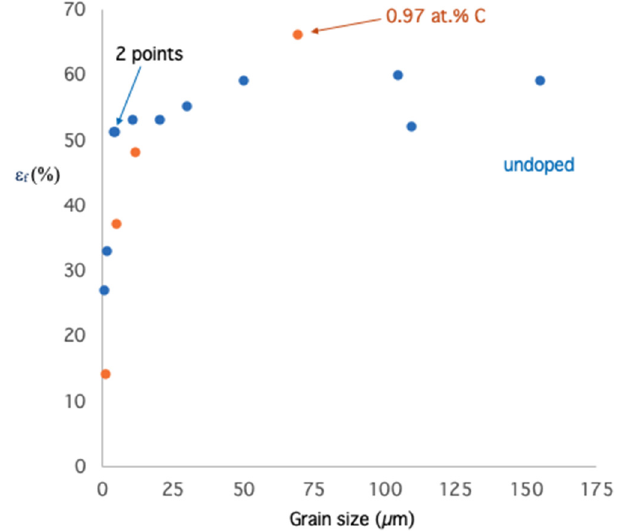
Figure 8. Elongation to fracture ( ε f ) at room temperature versus grain size for undoped equiatomic CoCrFeMnNi—black points (data from [18–20,28]), and for 0.97 at. % carbon doped CoCrFeMnNi—red points (data from [21]).